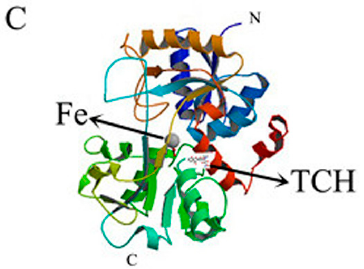
Figure 8. Spatial organizations of apo- and Fe-bLf (based on X-ray structural analysis).